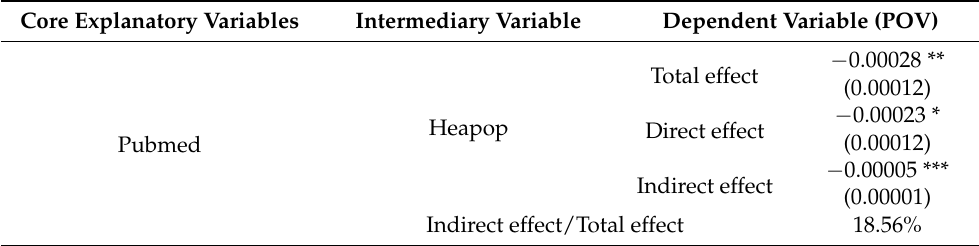
Table 4. Breakdown of the impact of public health services on poverty reduction.